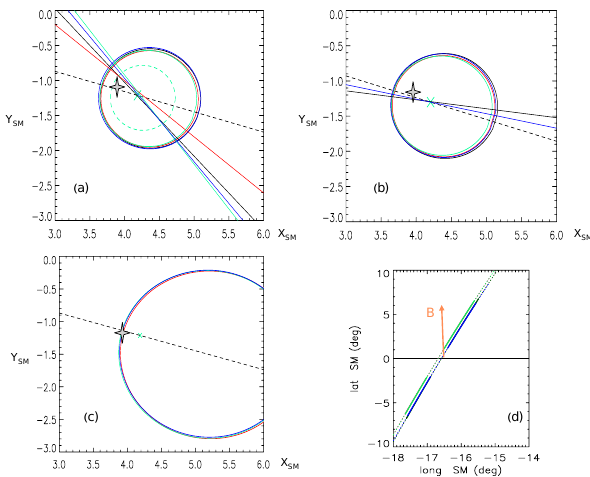
Fig. 5. Geometrical results for 70kHz radiation. Top: loci in the equatorial plane of sources which would have the Cluster C n spacecraft, at the time it observes maximum amplitude at 70kHz, at the centre of their beam, and the corresponding directivity paths (straight lines); colour codes for C n as in Fig. 4. Panel (a) northern beam (dashed green line: the locus and directivity for C3 if it were 1 ◦ latitude closer to the SM equator) and panel (b) for the south- ern beam. The green cross represents the position of C3, and the dashed black line the projected magnetic meridian plane at that po- sition. The grey star symbol shows the source position obtained by triangulation and plotted in Fig. 3. Bottom: (c) loci in XY plane of an off equatorial source (+0.65 ◦ latitude); (d) orbital positions of the four spacecraft and measured magnetic field orientation at equator (orange vector). Thick lines indicate the SM latitude and longitude of C3 and C4 when the signal at 70kHz was greater than half the peak